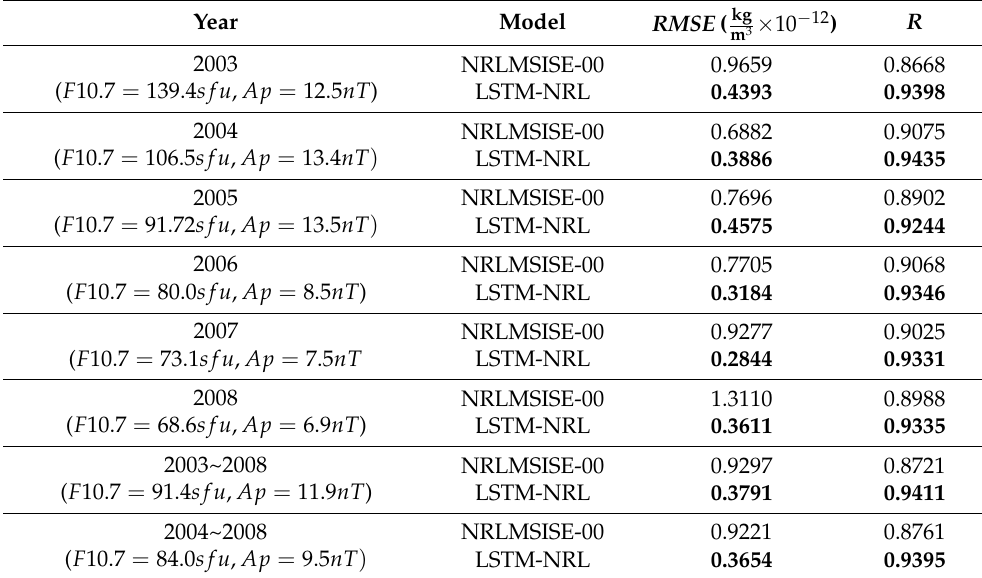
Table 7. The performance of the LSTM-NRL in 6 years from 2013 through 2018. It is noted that the best results, in terms of RMSE and R , are bold in the table.